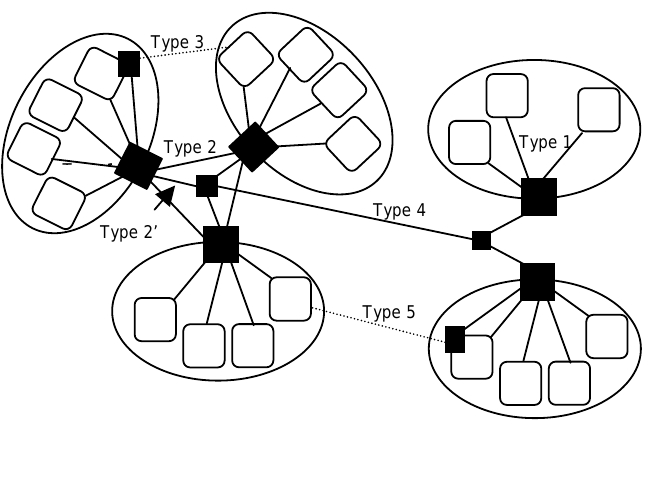
Figure 5: Proposed network